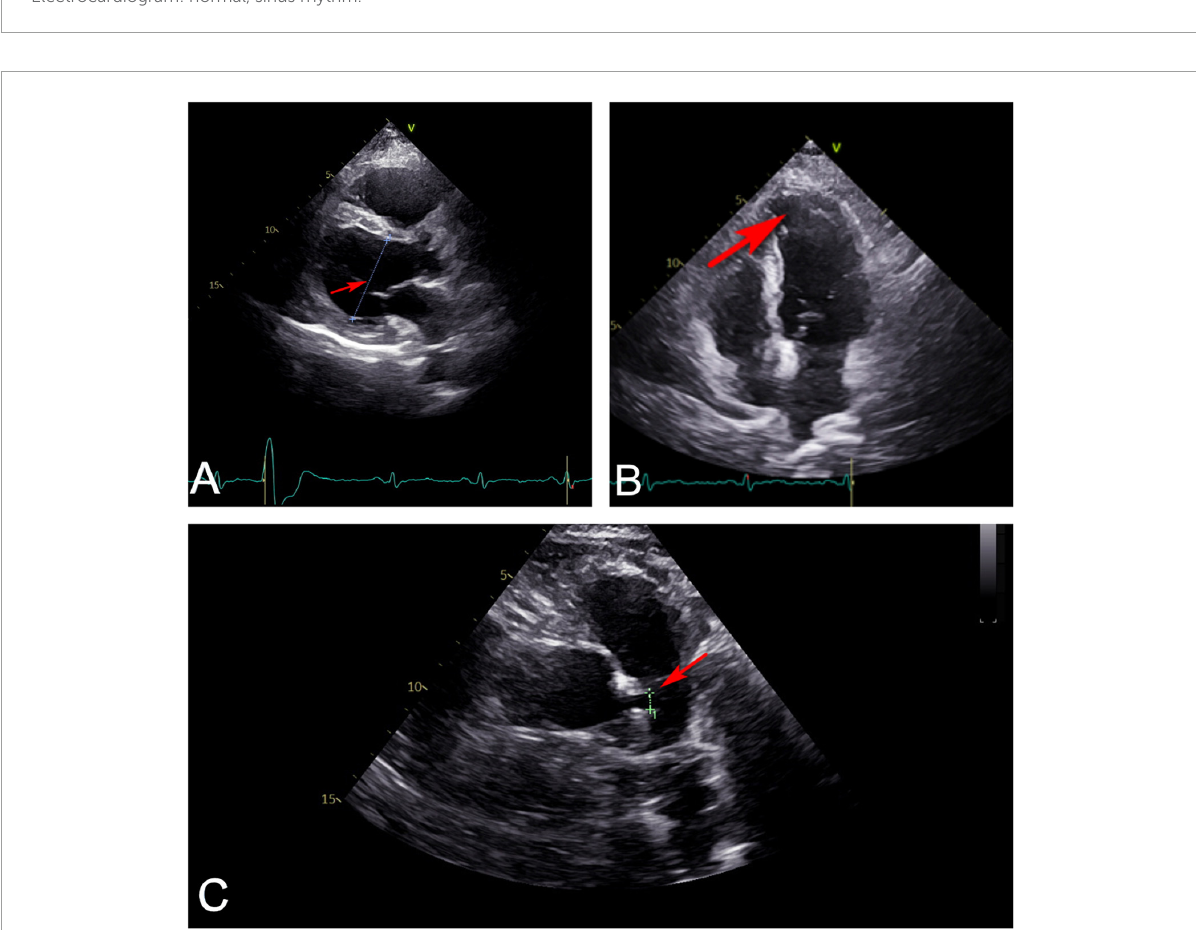
FIGURE2 Ultrasonic cardiography showed that (A) left ventricle (red arrow) slightly enlarged from the parasternal long axis section view. (B) Apex of left ventricle (red arrow) bulged slightly outward from four-chamber view. (C) Left main coronary artery (red arrow) widened from random